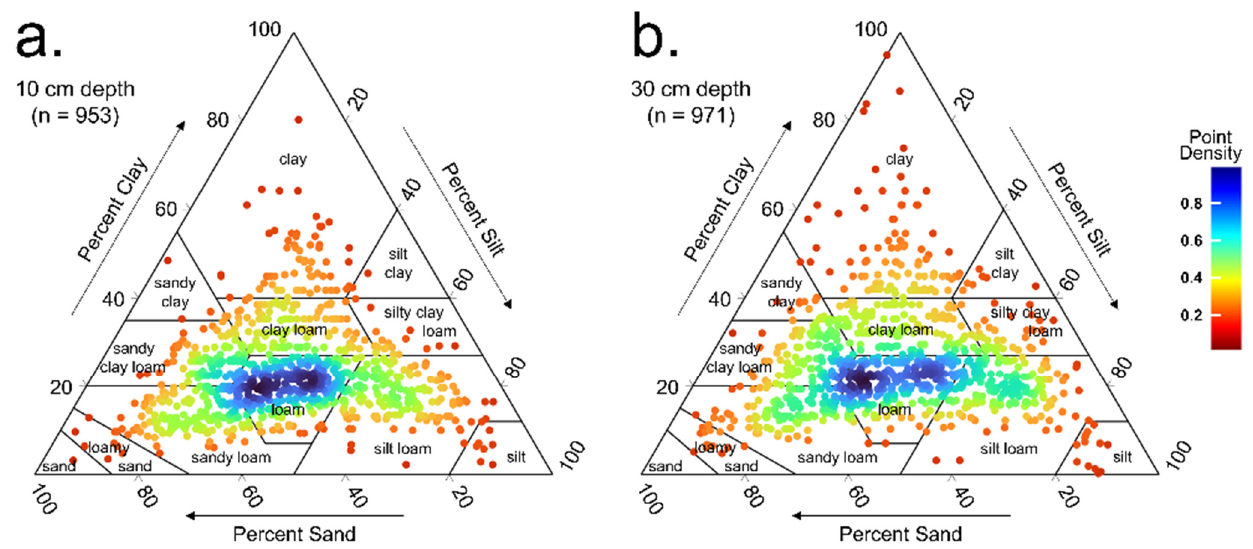
Figure 2. Soil texture distribution used in this study: ( a ) distribution of soil samples at 10 cm depth and ( b ) 30 cm depth. Twelve soil textures (<2 mm fraction) were determined according to USDA Textural Soil Classification.